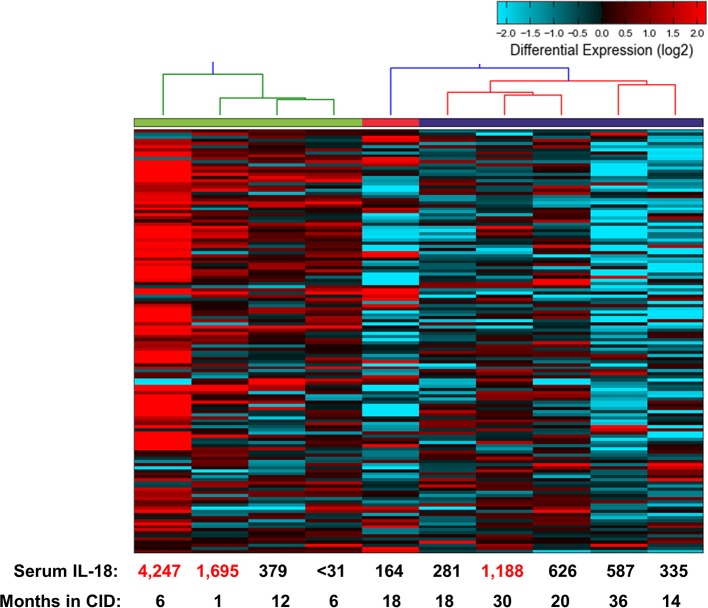
Proinflammatory gene expression signature in neutrophils from patients with CID. Unsupervised clustering performed using 139 upregulated DEGs identified as upregulated in neutrophils from active SJIA patients. Serum IL-18 levels at time of sample collection indicated on bottom. Numbers in red indicate values more than twice upper limit of normal.